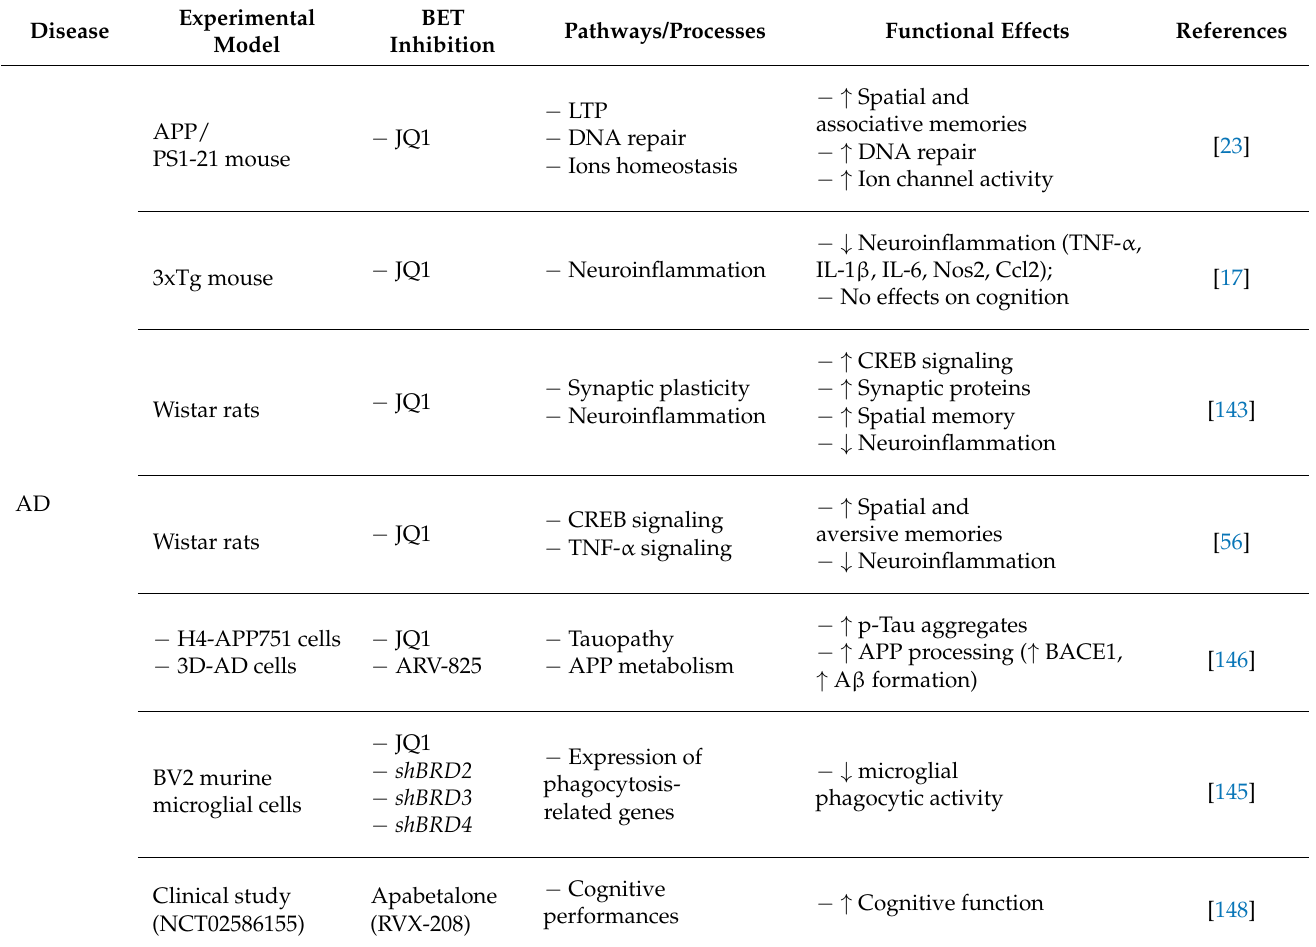
Table 1. Effects of BET inhibition in neurodegenerative disorders. ↑ indicates an increase; ↓ indicates a decrease. AD (Alzheimer’s disease); PD (Parkinson’s disease); HD (Huntington’s disease); ALS (Amyotrophic Lateral Sclerosis); FTD (FrontoTemporal